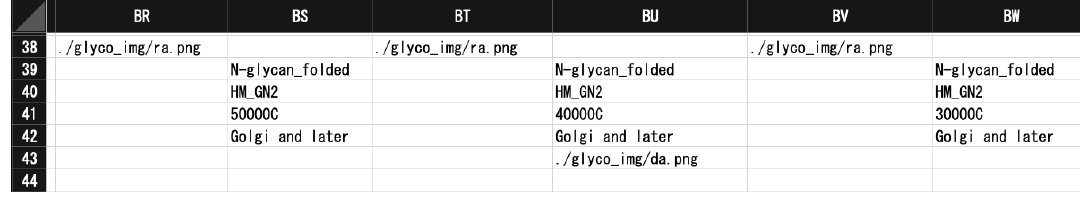
Figure 5. Part of the biosynthesis pathway map in comma-delimited files (CSV)